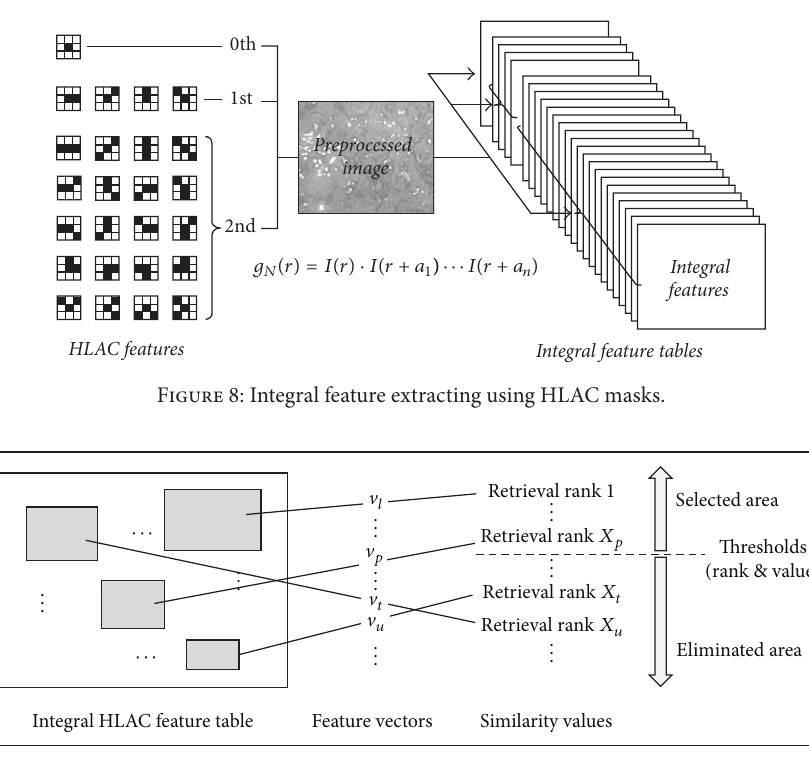
Figure 9: Area selection from the integral feature